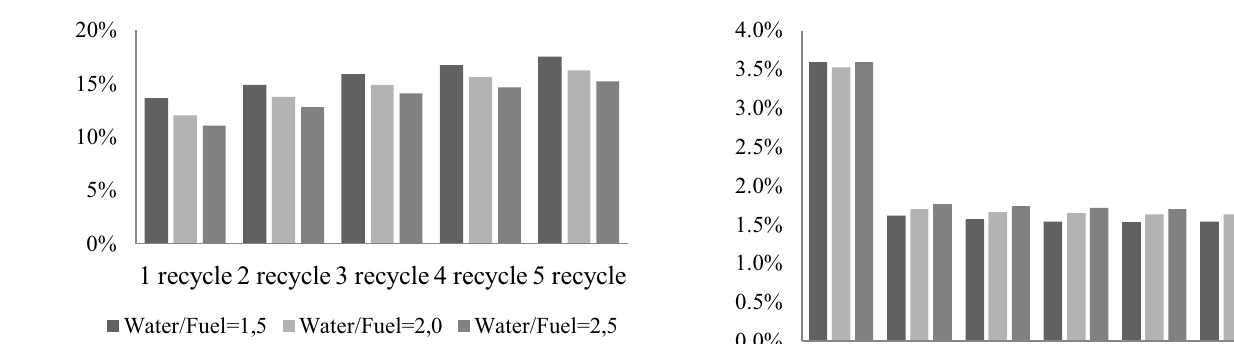
Fig. 8. The plutonium fraction in the fresh REMIX(MOX)-fuel (for each FA concepts).